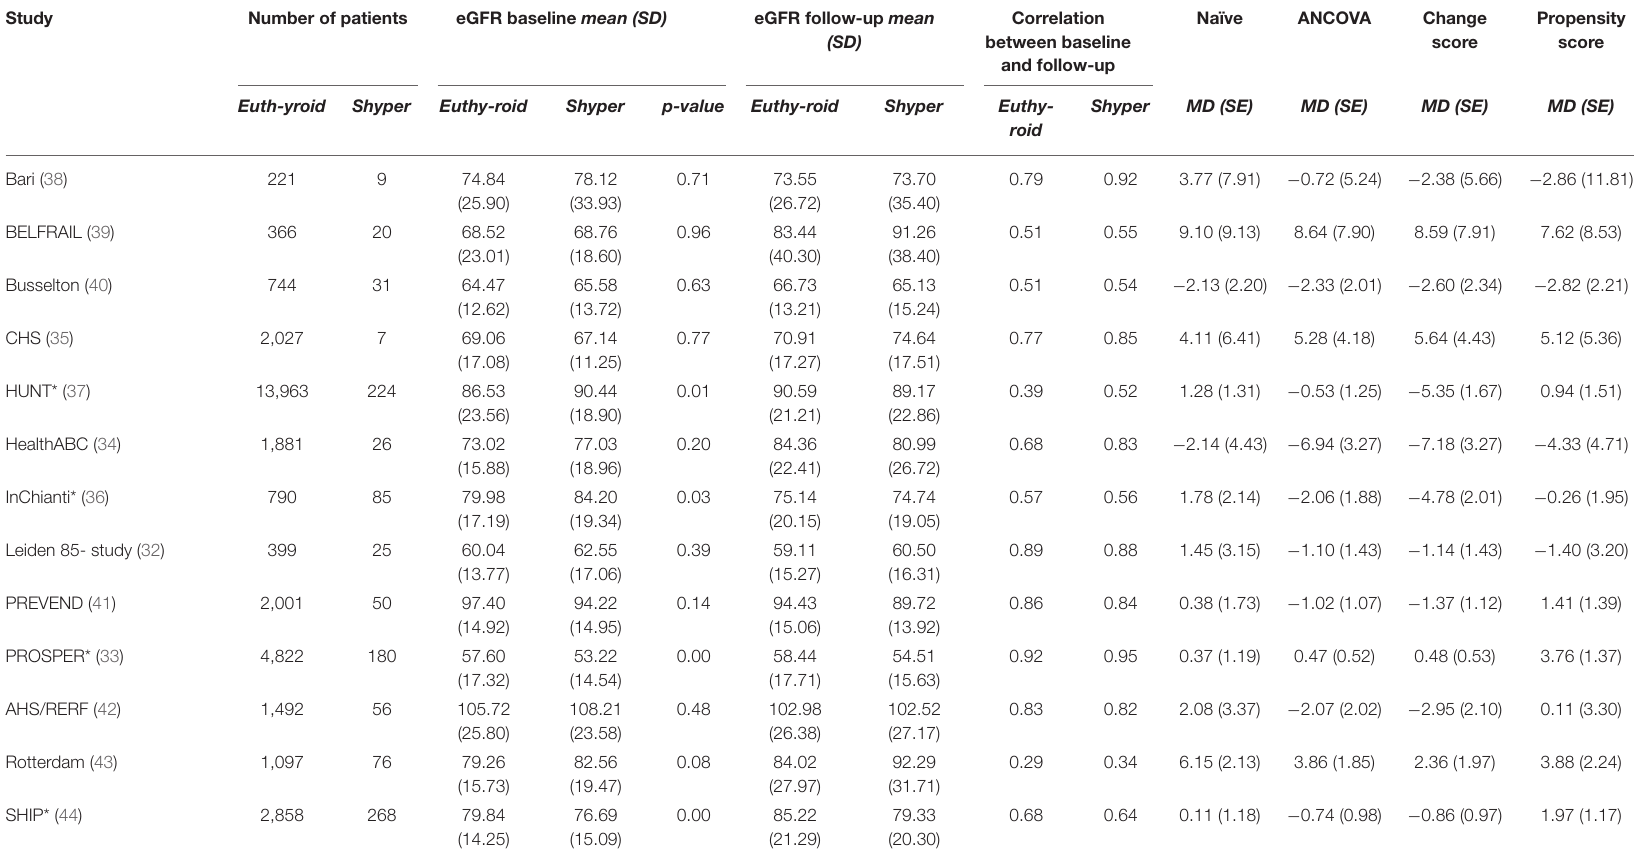
TABLE 4 | Individual non-randomized studies included in renal function application of the IPD MA. Study Number of patients eGFR baseline mean (SD) eGFR follow-up mean